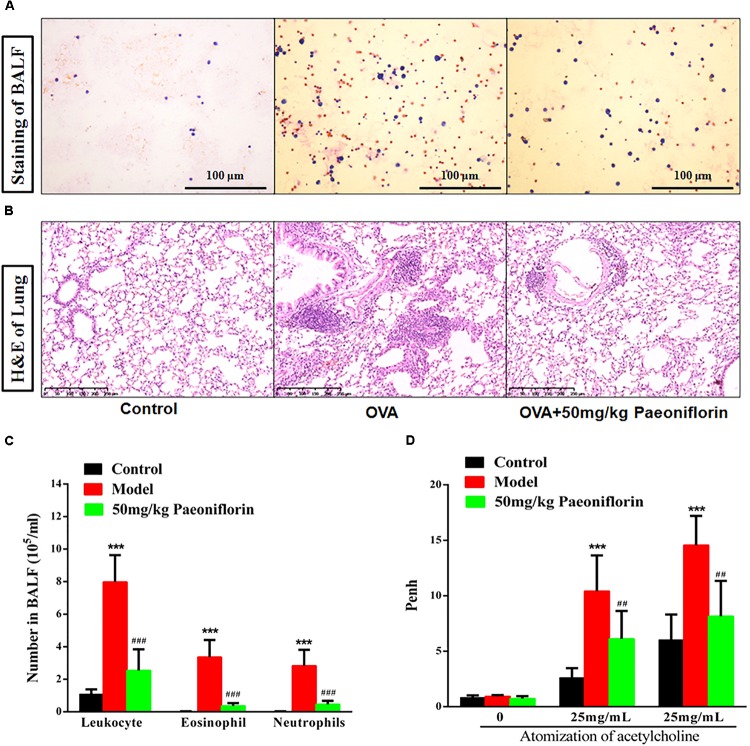
Paeoniflorin reduce inflammation and airway hyperresponsiveness in allergic asthma mice. The staining of BALF (A), lung tissue pathological changes and inflammation inflammatory infiltration (B), Leukocytes, EOS, and neutrophils level in BALF (C), and Penh level (D). The data were expressed as the mean ± SD. ∗Means control group vs model group (∗∗∗p < 0.001); #Means model group vs paeoniflorin group (##p < 0.01 and ###p < 0.001).